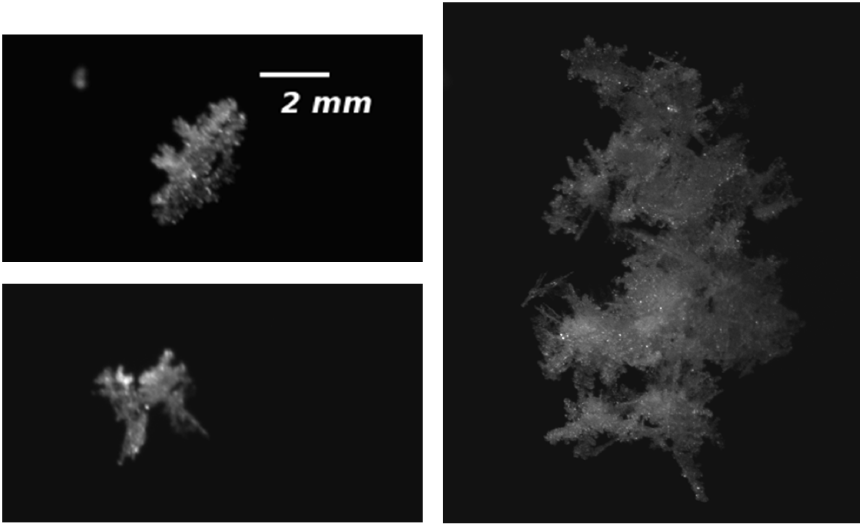
Figure 26. Selected MASC images starting at 21:41 UTC on 21 February 2015.